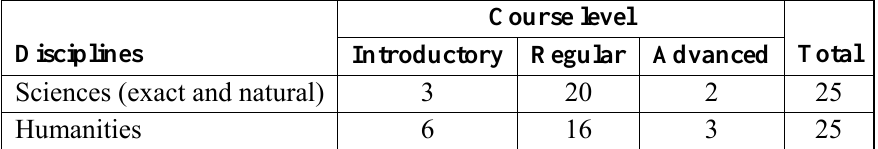
Distributions by Course Level